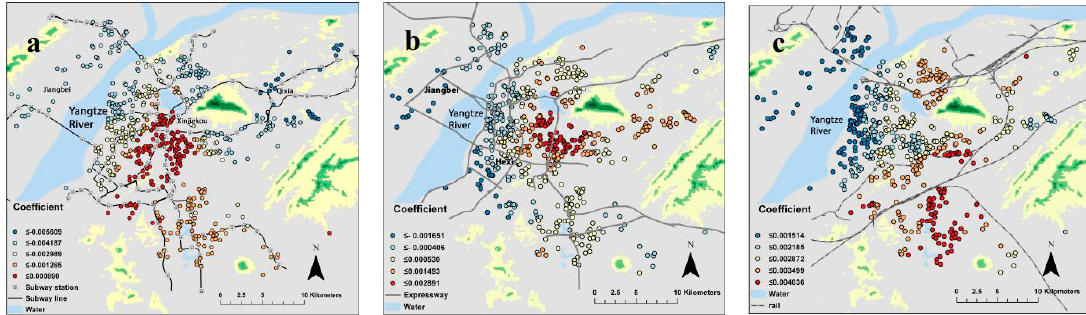
Figure 2. The spatial distribution of coefficients: ( a ) subway; ( b ) expressway; ( c ) railway line.